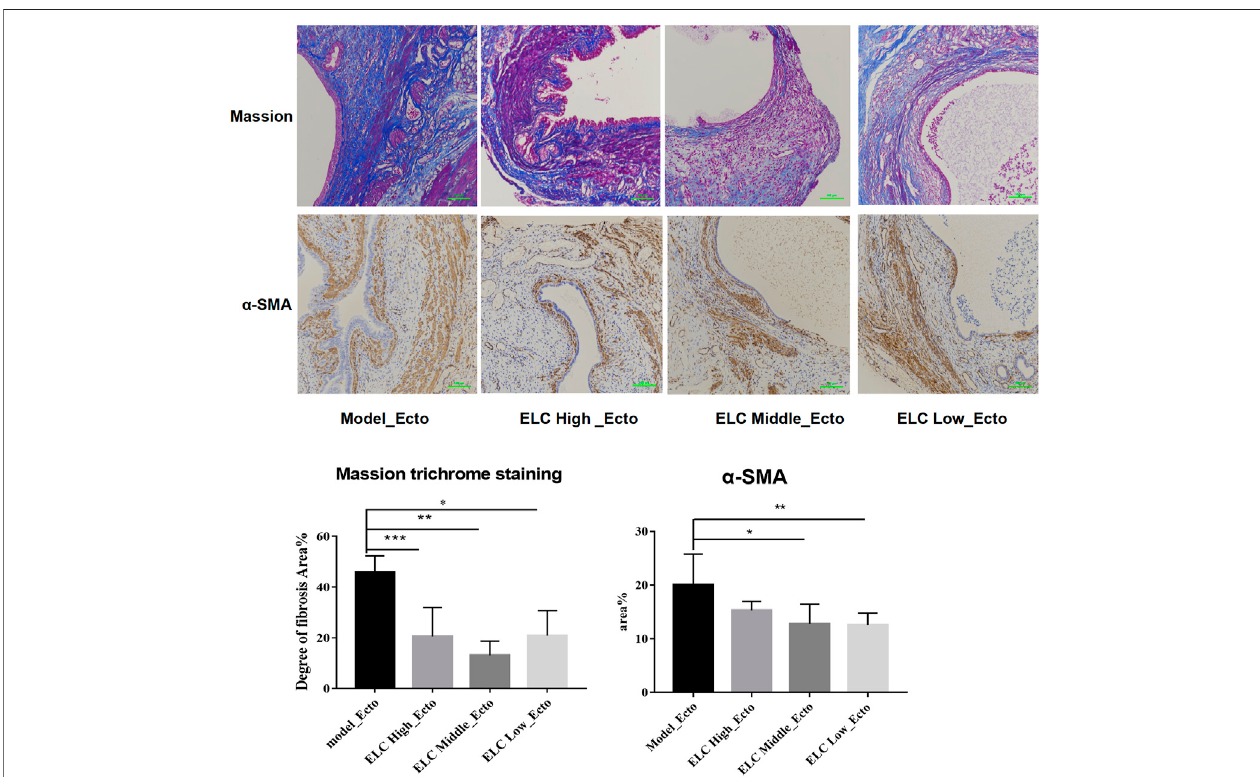
FIGURE 5 | Result of fi brosis in ectopic lesions in endometriosis model rats. Values are represented as mean ± SD, n (cid:2) 4. p < 0.05 as determined by one-way ANOVA. The Masson staining showed local fi brosis after modeling ( × 200). The percentage of fi brosis was positive by Masson staining of ectopic lesions in tissue sections.Comparedwiththemodelgroup,theELCgrouphasalowerdegreeofELC fi brosis.Valuesarerepresentedasmean ± SD( n (cid:2) 4)(* p < 0.05).ELCcouldreduce thedegreeof fi brosisofthelesion.Modelgroup:45.86 ± 6.42%,ELCHigh_Ecto:20.56 ± 11.41%,ELCMiddle_Ecto:13.06 ± 5.68%,andELCLow_Ecto:20.87 ± 9.93%. * p (cid:2) 0.0068; ** p (cid:2) 0.0009; *** p (cid:2) 0.0074 ( p < 0.05). Compared with that in the control eutopic endometrium, the fi brosis area (Area%) of the model group and ELCgroupincreasedsigni fi cantly( p (cid:2) 0.0457 < 0.05).Comparedwiththatinthemodelgroup,the fi brosisarearatiowasreducedintheELCmiddle-dosegroupandlow- dose group. * p (cid:2) 0.040; ** p (cid:2) 0.0346 ( p <